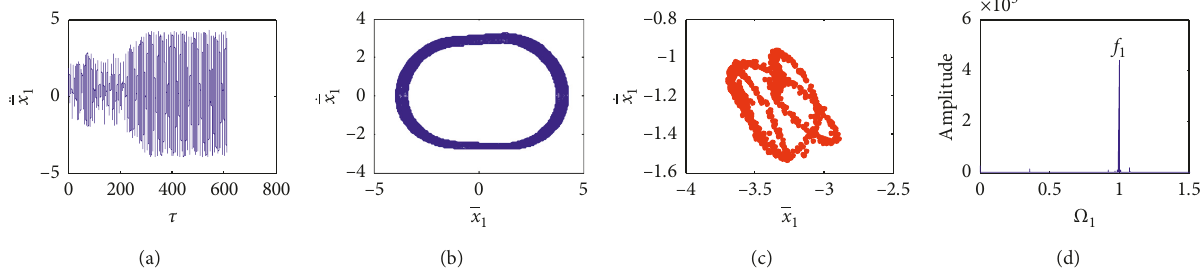
Figure 5: Vibration characteristics when Ω � 0.8: (a) time domain, (b) phase diagram, (c) Poincar´e section, and (d) frequency domain. 1